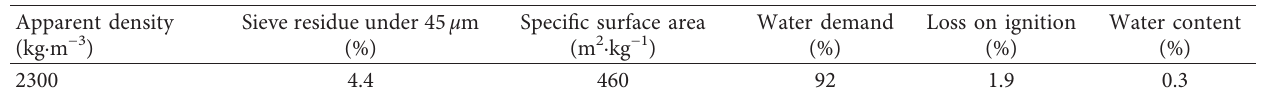
Table 2: Properties of fly ash.